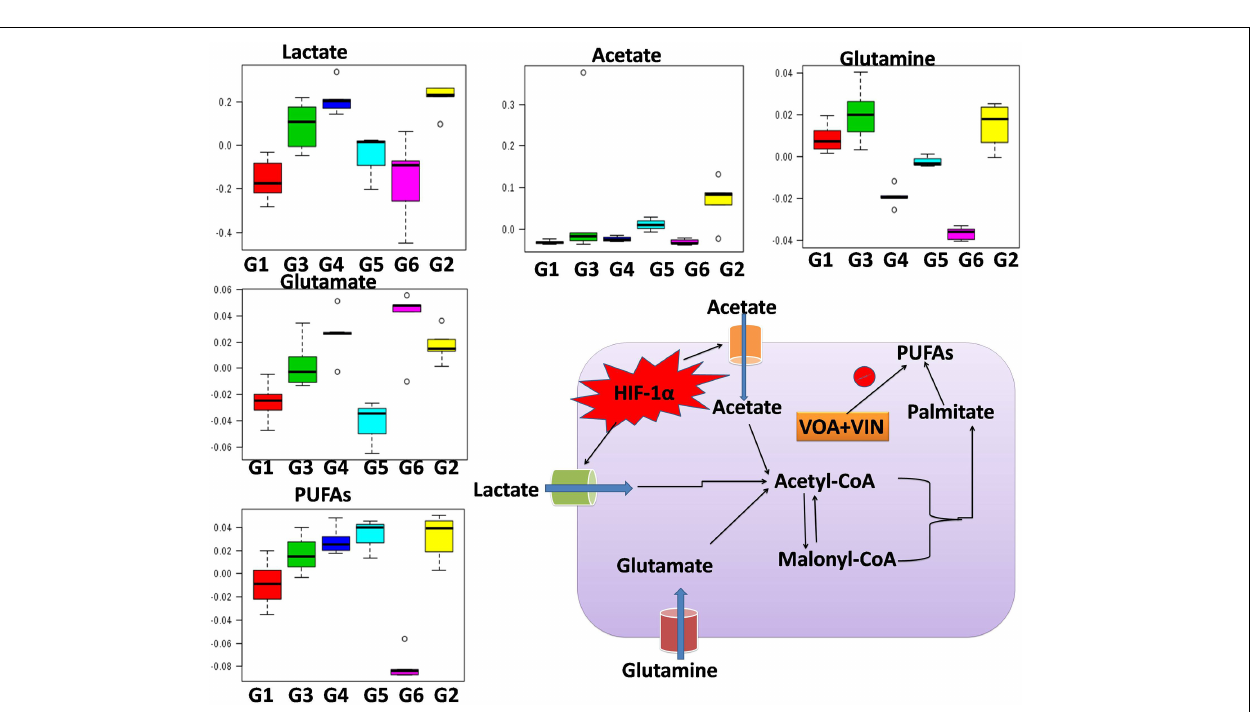
FIGURE 4 | Hypoxia alters metabolic reprogramming in cancer cells to enhance fatty acid synthesis. HIF-1 α shifts the metabolism of glucose through glycolysis, which fuels the fatty acid pathway. Also, glucose-derived citrate is insufficient to fulfill the heavy acid demand. Therefore, under hypoxia, cancer cells utilize abnormal metabolites like acetate, lactate, and glutamate to fuel the fatty acid